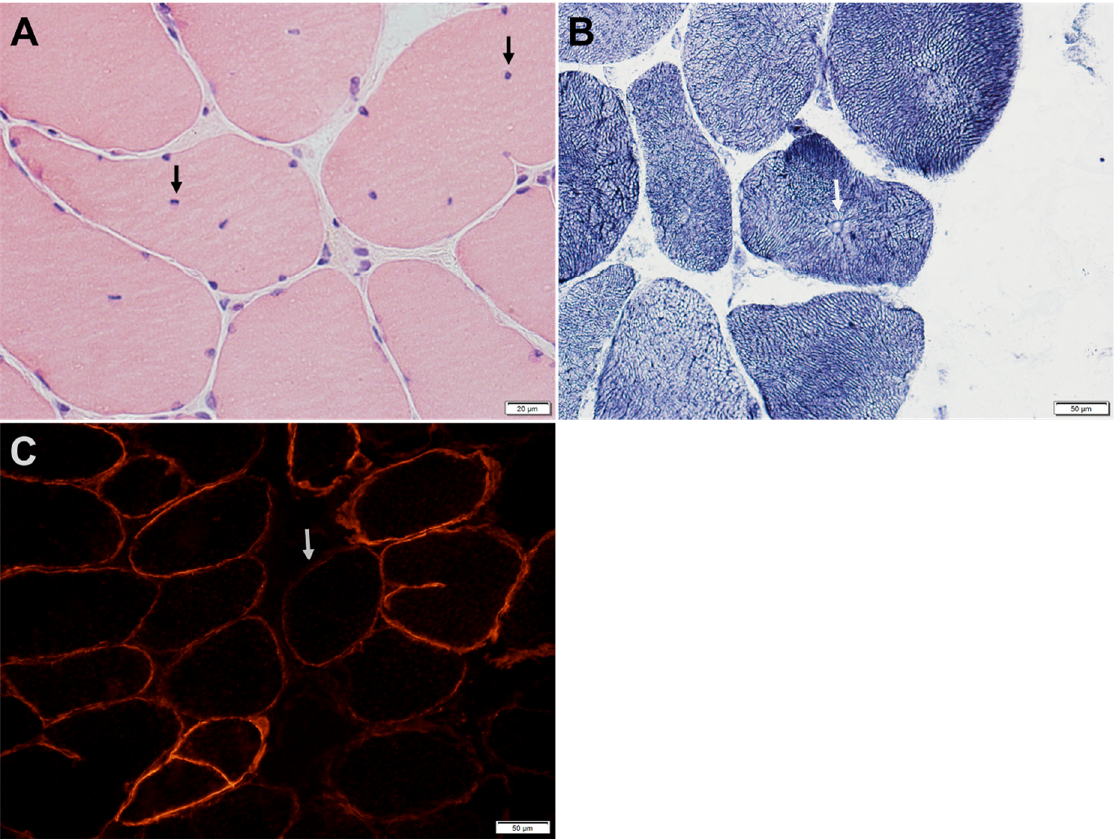
Figure 4. Intercostal muscle biopsy of a patient with GMPPB-related disorder manifesting with proximal weakness and defect of neuromuscular transmission. ( A ) H&E-stained section shows internalized nuclei (arrows) in several fibers. ( B ) Nicotinamide adenine dinucleotide dehydrogenase reacted sections shows central nucleation with radial arrangement of myofibrils (arrow). ( C ) Immunohistochemical stain for α -dystroglycan shows patchy reduction of α -dystroglycan immunoreactivity (arrow shows a representative fiber) at the sarcolemma of many muscle fibers.